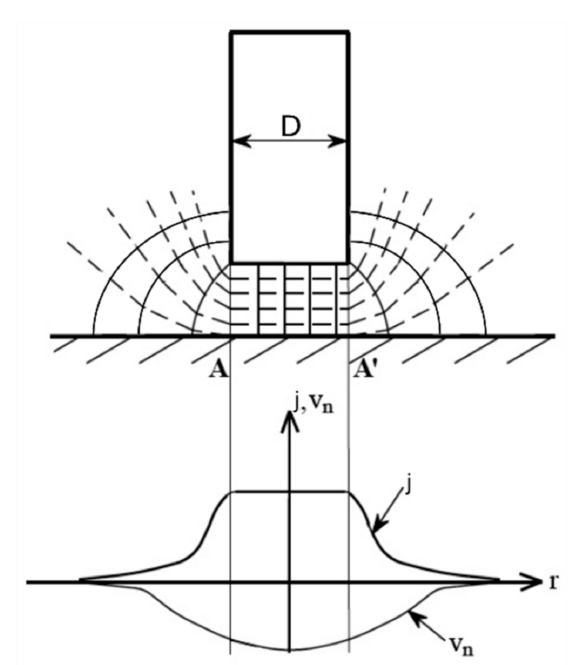
Figure 2. Scheme of machining area showing the electric field intensity distribution, corresponding current density j and electrochemical dissolution ratio (speed v n ) distribution; D —tool